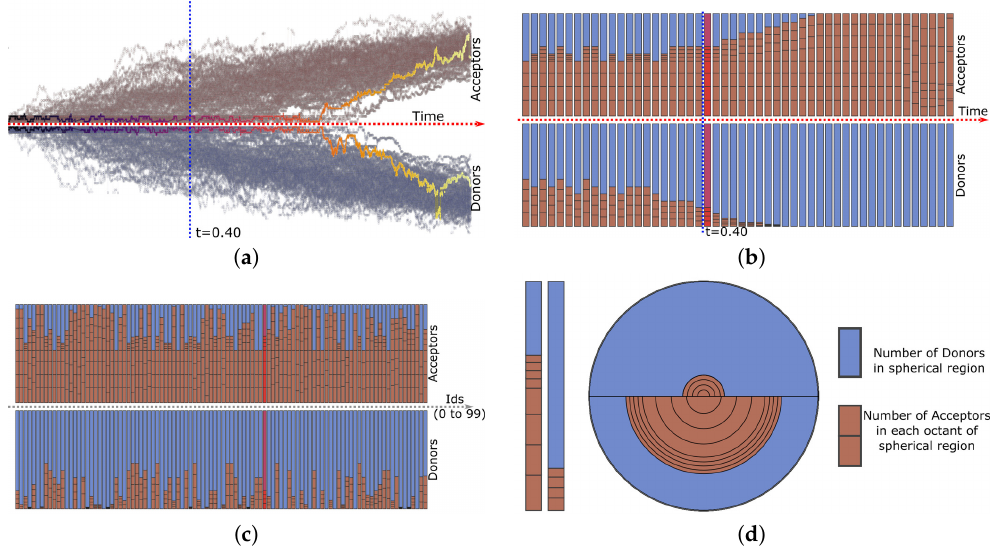
Figure 7. Interactive plots of morphology composition of single trajectory and ensemble. ( a ) selected distance measure at a certain time step, with one selected trajectory pair highlighted ( b ) acceptor-donor ratio along selected trajectory. ( c ) morphology composition of all trajectories at a specific time step t = 0.4. ( d ) stack and radial plot for octant acceptor-donor ratio of selected trajectory at specific